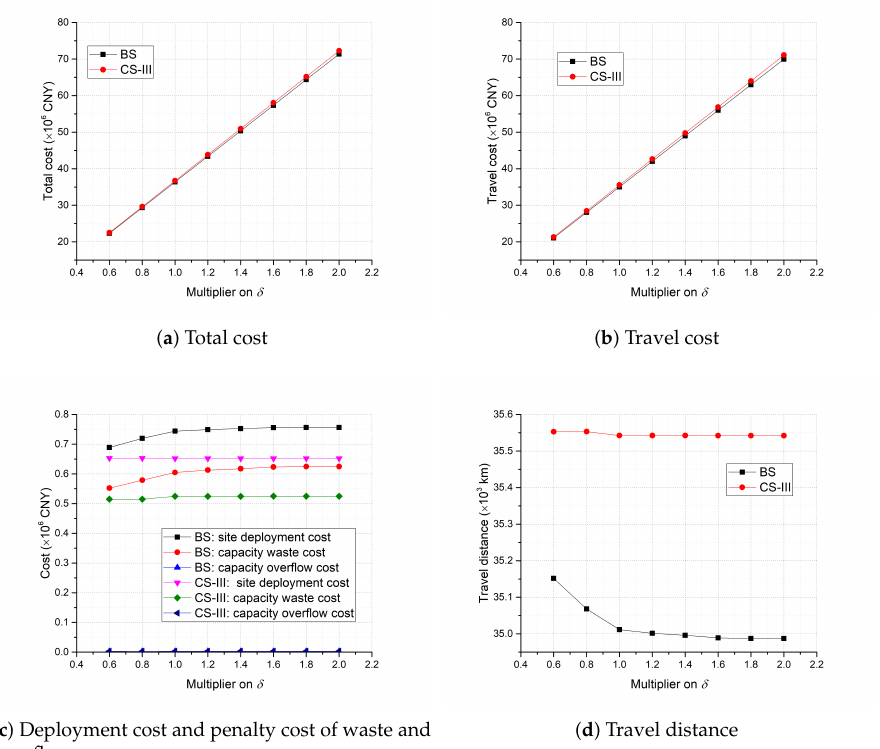
Figure 7. Sensitivity analysis on δ